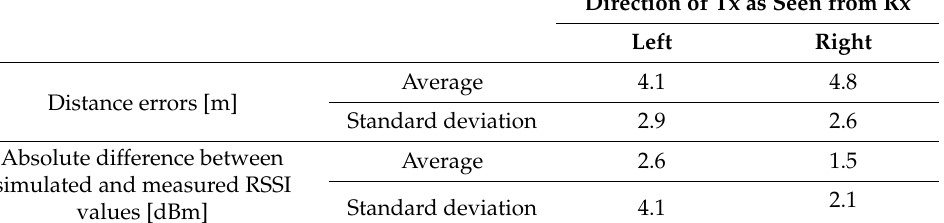
Figure 18. Overview of the point at which Rx and Tx move.